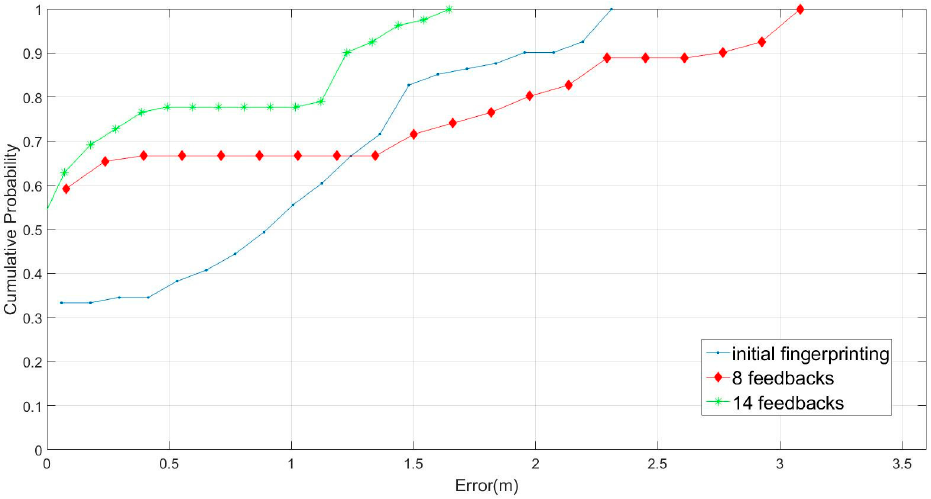
Figure 11. Field experiment with eight- and fourteen-feedbacks.